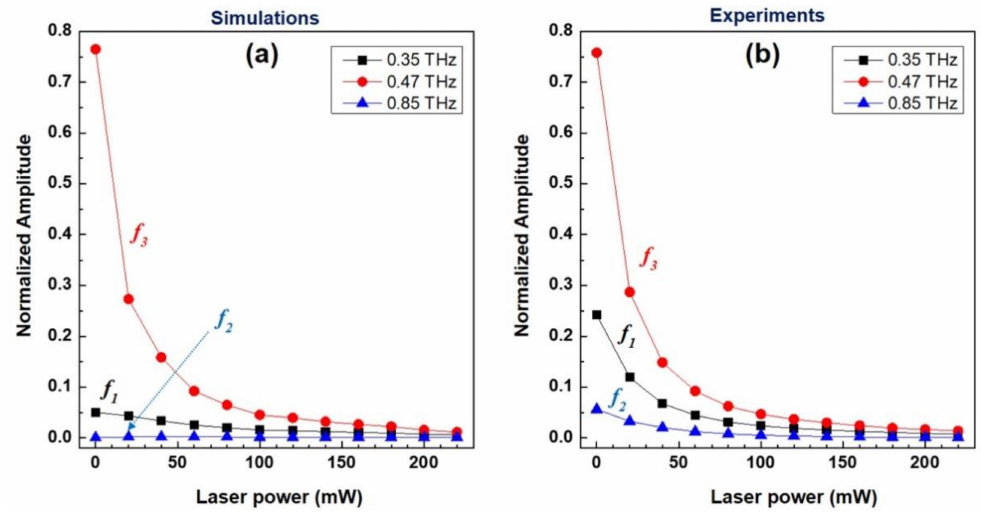
Figure 3. The intensity values, extracted at the frequencies of f 1 , f 2 and f 3 , of the ( a ) simulated and ( b ) measured transmission spectra.